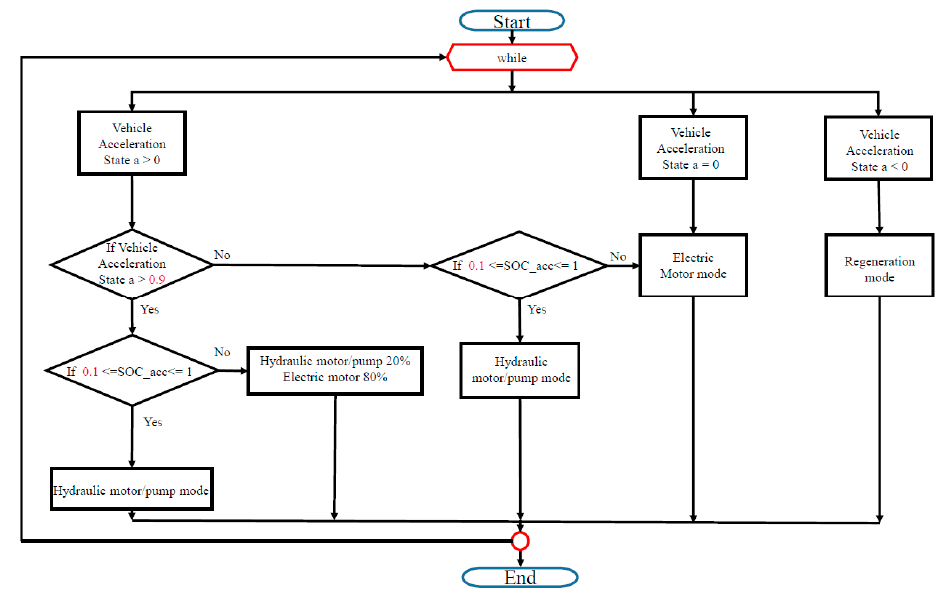
Figure 7. Updated control strategy from genetic algorithm.